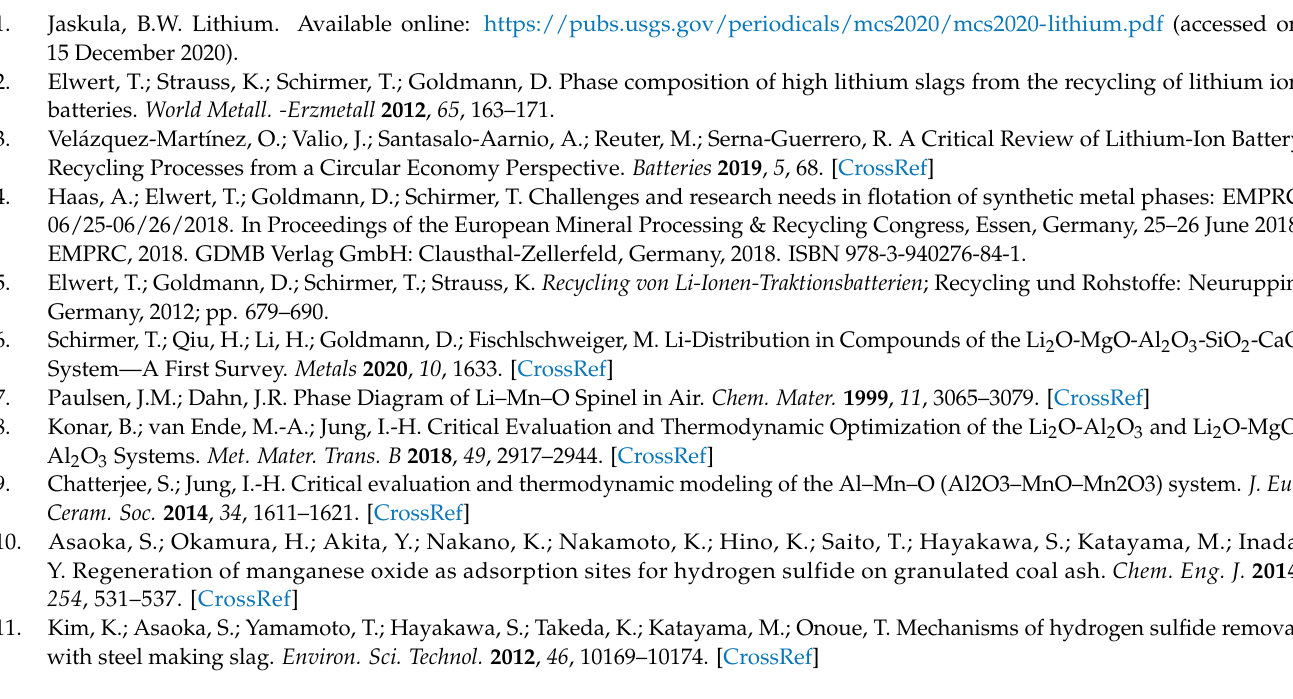
Figure A3. Linear combination of hausmannite (H) and bixbyite (B).